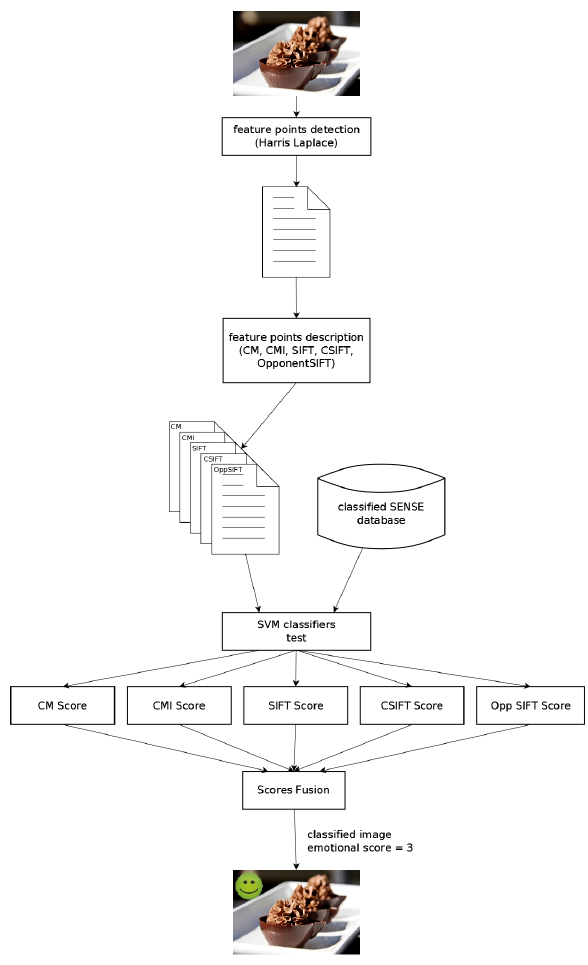
Figure 10. Emotional score